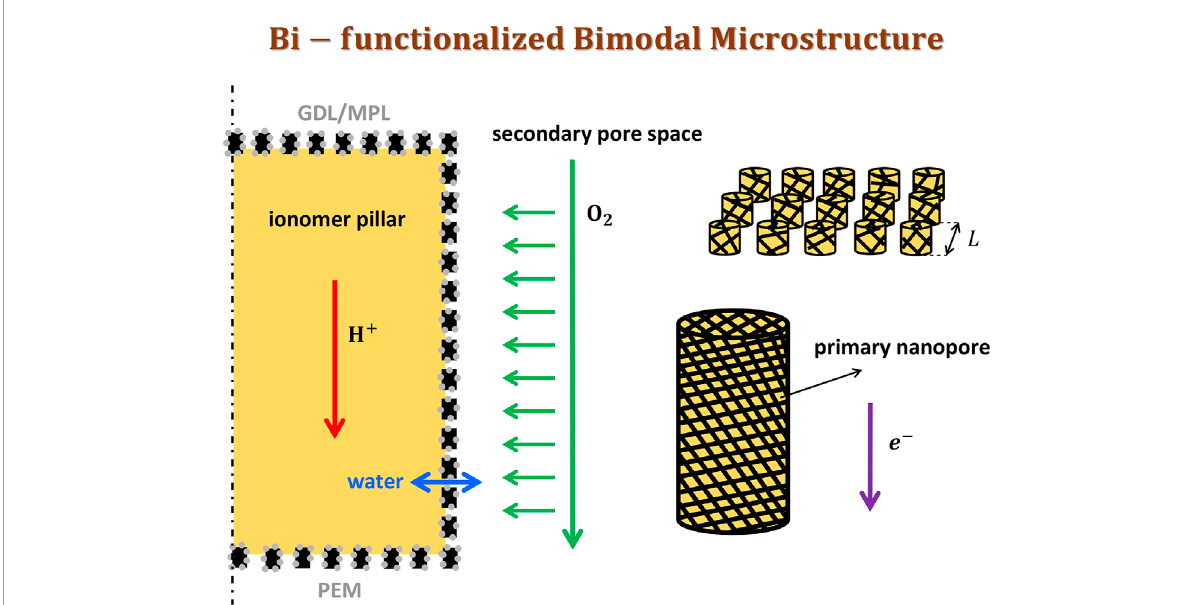
FIGURE 2 Schematic of a bi-functionalized bimodal cathode CL microstructure with targeted domains for proton and gas species transport, and a primary ( R ≲ 10 nm)/secondary ( R ≳ 10 nm) pore size distribution. ORR and electron transport take place in a nanoporous shell covering ionomer pillars, which is made of a highly electron-conductive material catalyzed with Pt. Liquid water can be transported both through ionomer pillars and released to secondary pores. The characteristic spacing between pillars is L